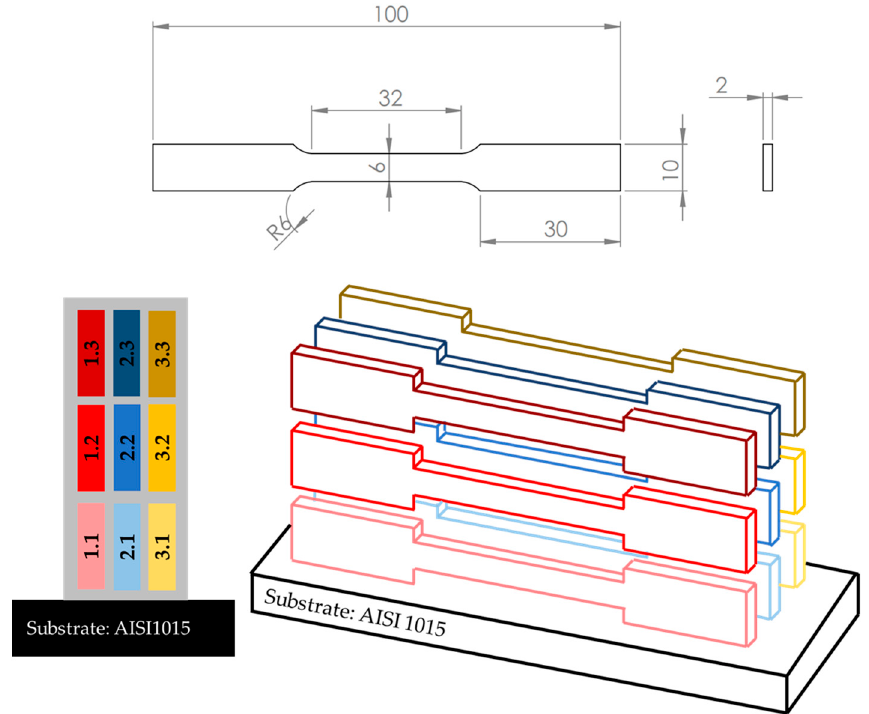
Figure 7. Tensile test sample geometry (in millimeters) and positioning of tensile test samples extracted from the produced sample walls.